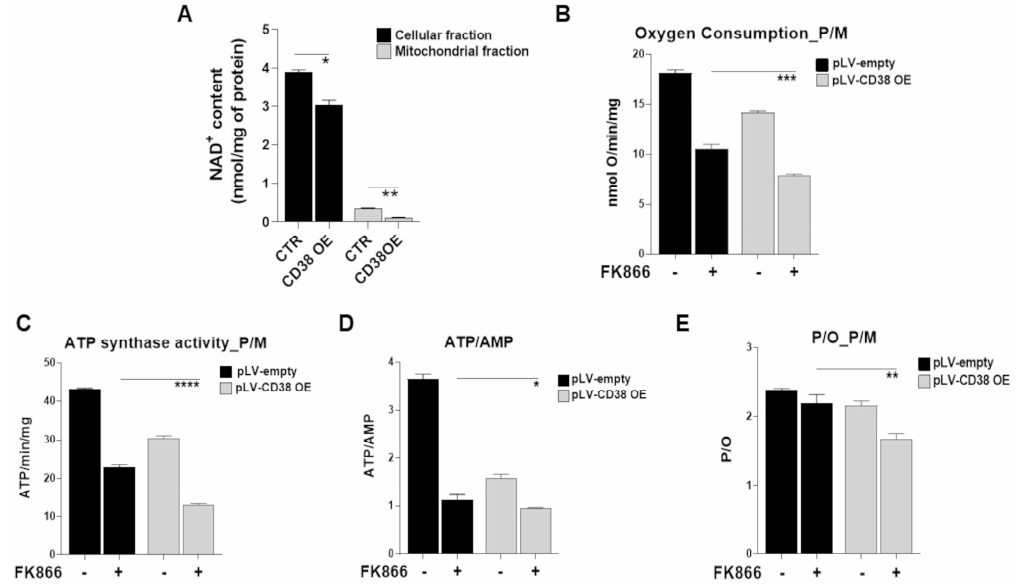
Figure 6. Metabolic reprogramming elicited by CD38-overexpression identifies a novel druggable vulnerability in MM cells. ( A ) Cellular and mitochondrial NAD + contents were measured in H929 CD38 OE or control cells and normalized to the protein content of each fraction. ( B ) Oxygen consumption, ( C ) activity of Fo-F1 ATP synthase, ( D ) energy status expressed as ATP/AMP ratio, and ( E ) oxidative phosphorylation efficiency as P/O ratio were measured in H929 control and CD38 OE cells. Data are presented as the mean ± SD of three different experiments. (* p ≤ 0.05, ** p ≤ 0.01, *** p ≤ 0.001, **** p ≤ 0.0001; unpaired t -test).